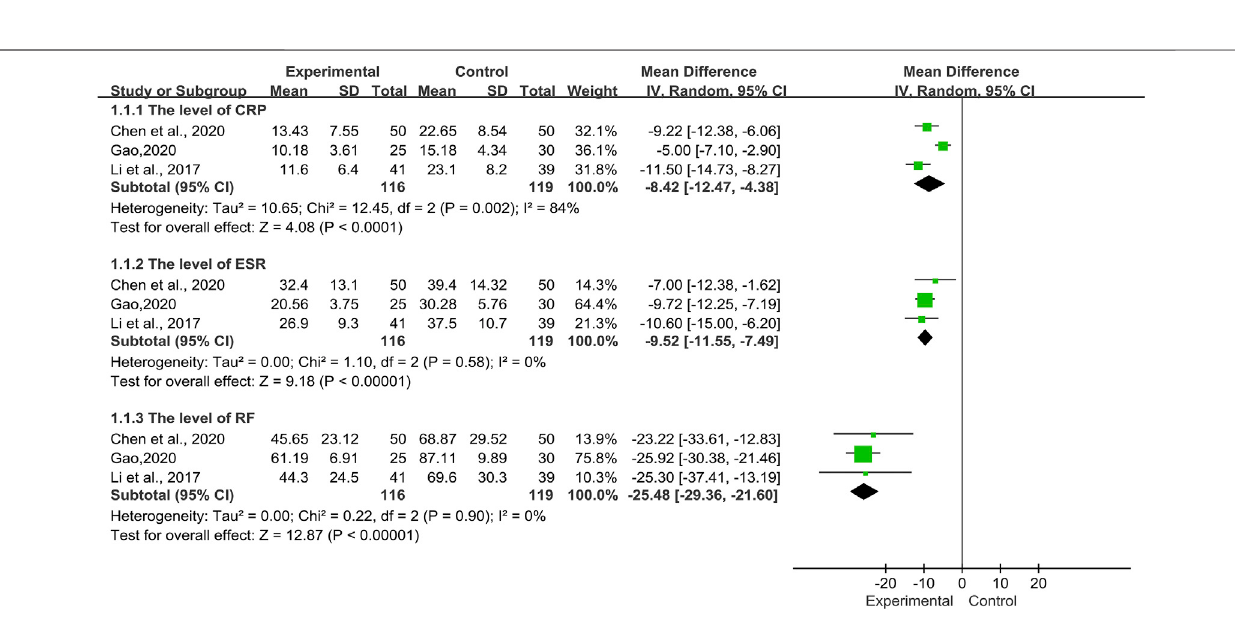
FIGURE 7 | Forest plot of the level of laboratory indicators with TwHF combined with conventional treatment versus pure conventional treatment.